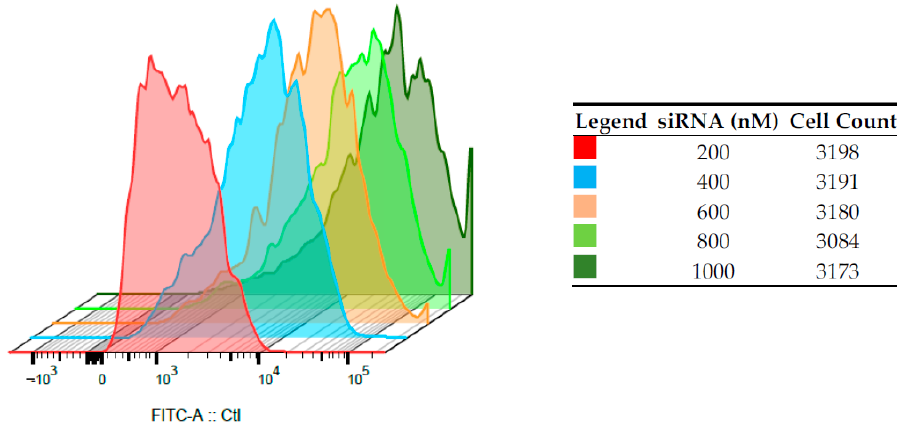
Figure 5. Intracellular fluorescence intensities on HepG2 of FITC-siRNA/CS-NPs complexes pre- pared at different siRNAs concentrations, determined by flow cytometry ( n = 3).